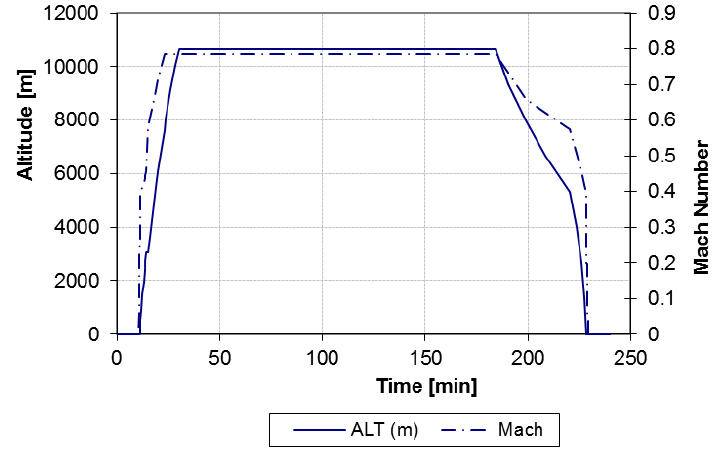
Figure 2: Mach no and altitude variation.